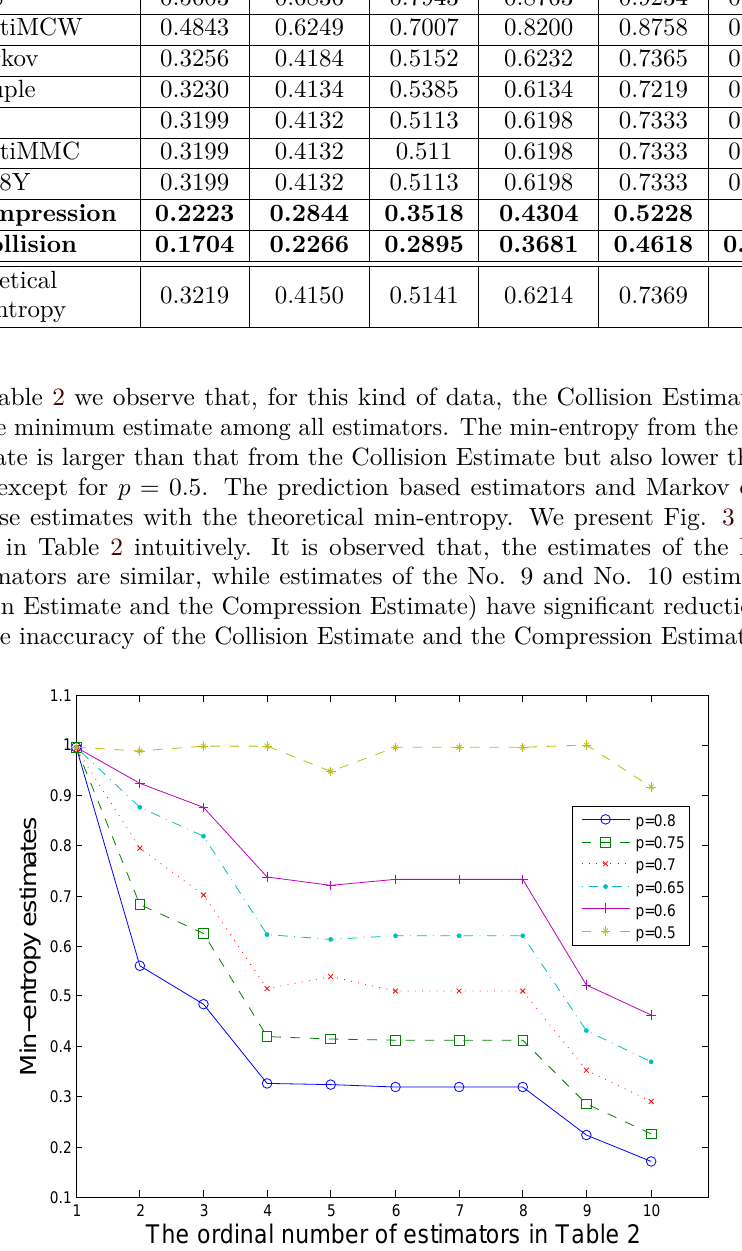
Figure 3: Min-entropy estimates of the NIST estimators for the first-order Markov progress IID source. To confirm that the Collision Estimate also underestimates the perfectly random entropy sources, we choose several popular PRNGs including Blum-Blum-Shub generator (BBS) [BBS86], Linear Congruential Generator (LCG), Modular Exponentiation Generator (MODEXPG), and Micall-Schnorr Generator (MSG). We employ these